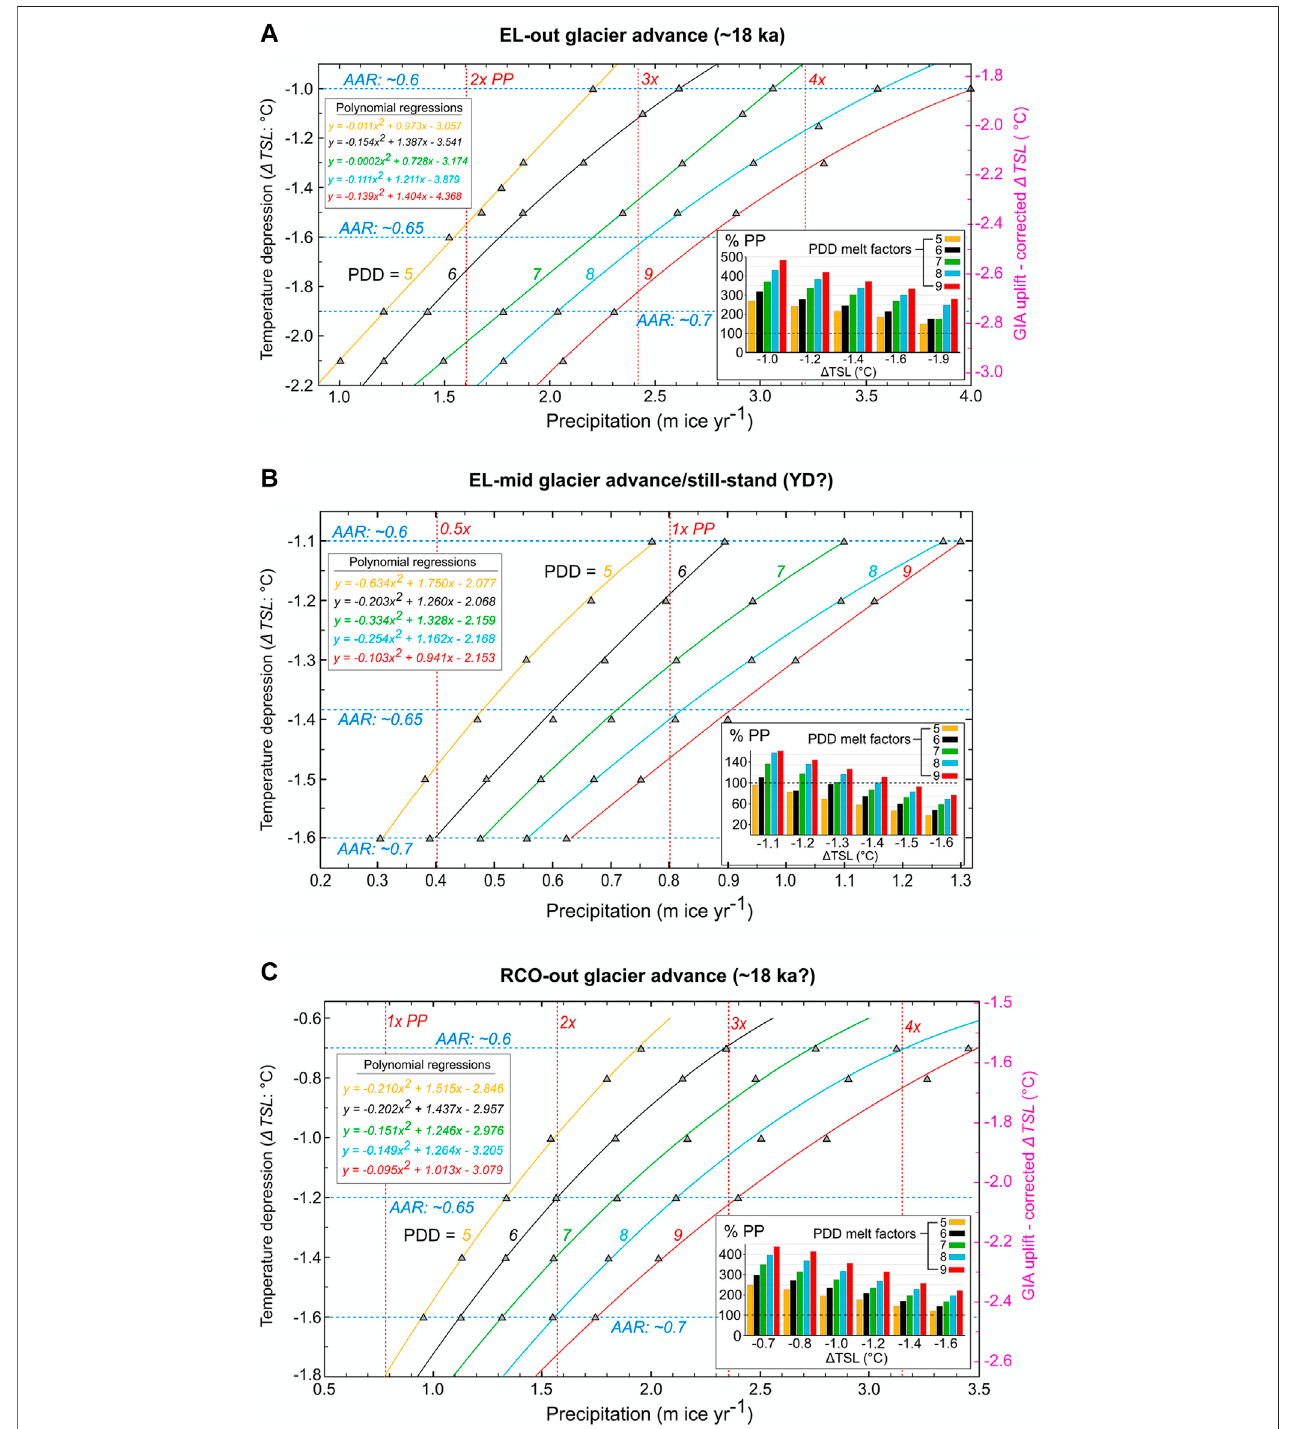
FIGURE 8 | Ice- fl ow model temperature depression and precipitation parameter combinations for each moraine-matching simulation (grey triangles) of the EL-out advance (A) ,theEL-midadvance/still-stand (B) andtheRCO-outadvance (C) ,foragivenround-numberpositivedegree-daymeltfactorvaluebetween5.0and9.0 mm w.e. d − 1 ° C − 1 . Each graph displays colour-coded second-degree polynomial regression curves and equations for each round-number positive degree-day melt factor (n (cid:1) 5). All regression equations are associated with R 2 values > 0.99. Each diagram also display histograms indicating the % precipitation associated with each simulation relative to present precipitations (% PP) values, for a given temperature depression value and degree-day melt factor (colour-coded bars). The horizontal dashed line represents modern precipitation (100%). Note that GIA-corrected temperature depressions include the hypothetical assumptions that the EL-mid advance/ still-stand dates to the YD ( ∼ 12 ka), and that the RCO-out advance is coeval with the EL-out advance ( ∼ 18 ka).